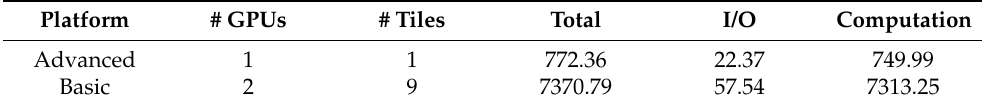
Table 7. Execution time (in seconds) for density estimation with ‘rule-of-thumb’ fixed bandwidth (no edge effect correction) on a synthetic dataset ( n = 1,000,000 points; density raster cell size =